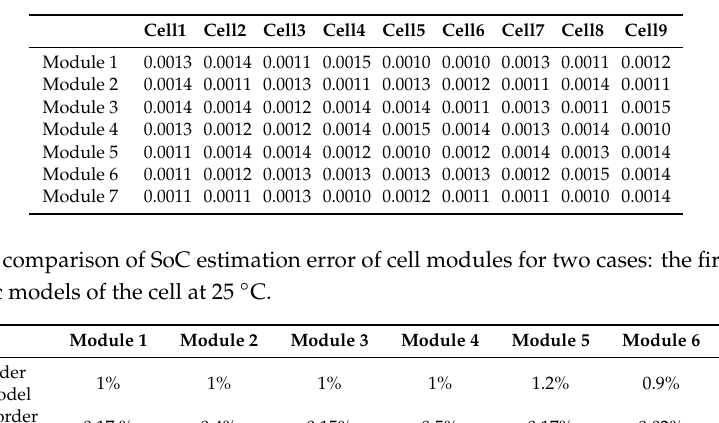
Table A2. The initial resistances R 0 of the cells in the LiBP at 25 ◦ C ( Ω ).